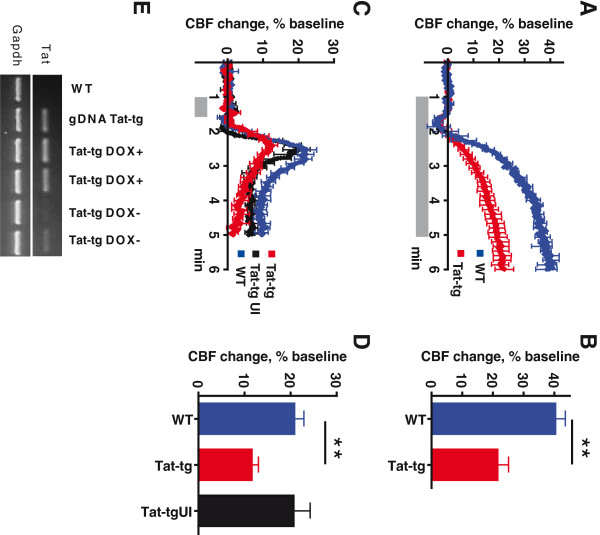
Tat-transgenic mice display attenuated cerebrovascular response to hypercapnic challenge. (A) Cerebral blood flow (CBF) change in response to 5-minute exposure to 6% CO2, as measured by laser Doppler flowmetry (LDF). Results represent mean from seven Tat-transgenic (Tat-tg) mice and four wild type (WT) mice. (B) Maximum CBF reached in response to exposure to 6% CO2, for the data shown in (A). **P <0.01, nonparametric permutation test. (C) CBF change in response to 30-second exposure to 6% CO2, as measured by LDF. Results represent mean from five Tat-tg mice, four Tat-tg mice not induced with doxycycline (DOX) (Tat-tg UI) and five WT mice. (D) Maximum CBF reached in response to exposure to 6% CO2, for the data shown in (C). **P <0.01, nonparametric permutation test. (A, C) Values are expressed as a percentage change from baseline CBF, defined here as the mean CBF measured during the one-minute period immediately preceding delivery of CO2. Shadowed area along X-axis represents duration of hypercapnic challenge. All data represent mean ± SEM. (E) Confirmation of inducible Tat expression in the cortex of Tat-tg mice, as analyzed by RT-PCR. A 141-bp Tat-specific PCR product is shown in the upper panel and a control 480-bp GAPDH product is shown in the lower panel. DNA-free RNA samples were analyzed from a WT c57Bl mouse (negative control), two Tat-tg DOX+ mice, two Tat-tg DOX- mice; genomic DNA from a Tag-tg mouse was used as a positive control (gDNA Tat-tg)